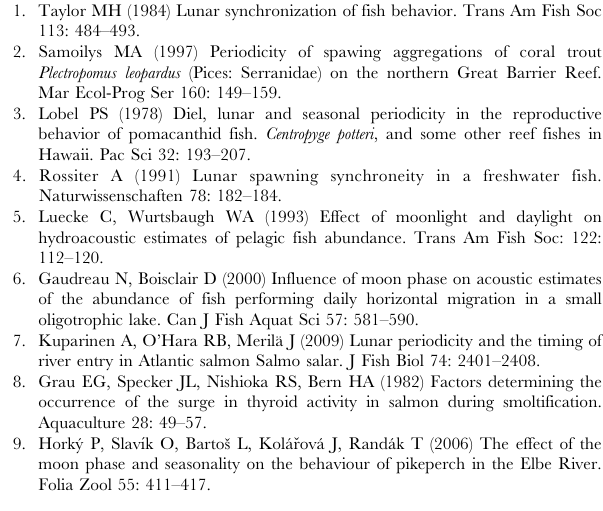
Figure S4 Regression diagnostic plots for the effect of lunar day on all fish caught in daytime and on angler effort at Lake Vermilion. Normal probability plots (top row) show that residuals are approximately normally distributed. Residual plots (bottom row) show that a linear model is appropriate and that residuals are homoscadistic. Regression statistics give in Table 1. Figure S5 Total number of fish caught by day of the week from the Muskies Inc. dataset (Plot A). Total number of anglers by day of the week from state Department of Natural Resources creel data. Data combined for Wisconsin, Lake Vermilion, and Mille Lacs (Plot B). Number of occurrences of selected days of the week by lunar day for the period of record of the Muskellunge Inc. data (1970–2013; Plot C). The expected number of occurrences of each lunar day during the period of record absent a lunar effect is 78.4. Figure S6 Percent of muskellunge catch by month and latitude. Each color sums to 100%. Figure S7 LOESS and periodic regression results for catch records for selected locations. Dashed regression lines are for the best two-predictor periodic regression model (regression statistics in Table 1). Solid lines are the LOESS fit with sampling proportion =